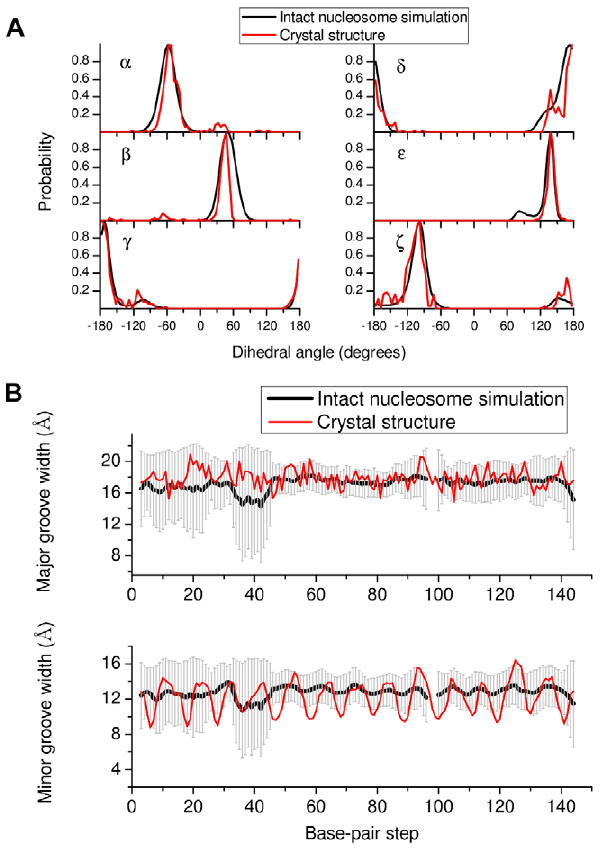
Figure 6. NA backbone and groove characteristics. (A) Probabil- ity distributions for DNA backbone dihedral angles. The dihedral angles a (O3’-P-O5’-C5’), b (P-O5’-C5’-C4’), c (O5’-C5’-C4’-C3’), d (C5’-C4’-C3’-O3’), e (C4’-C3’-O3’-P) and f (C3’-O3’-P-O5’) obtained from the intact nucleo-